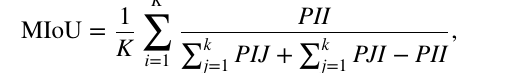
Fig. 13 Recommended IoT system for plant disease recognition in smart agriculture